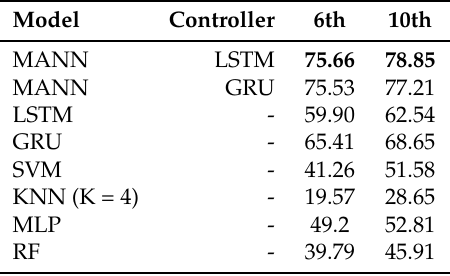
Table 10. Accuracies of the first ten instances without training in Domain 2.